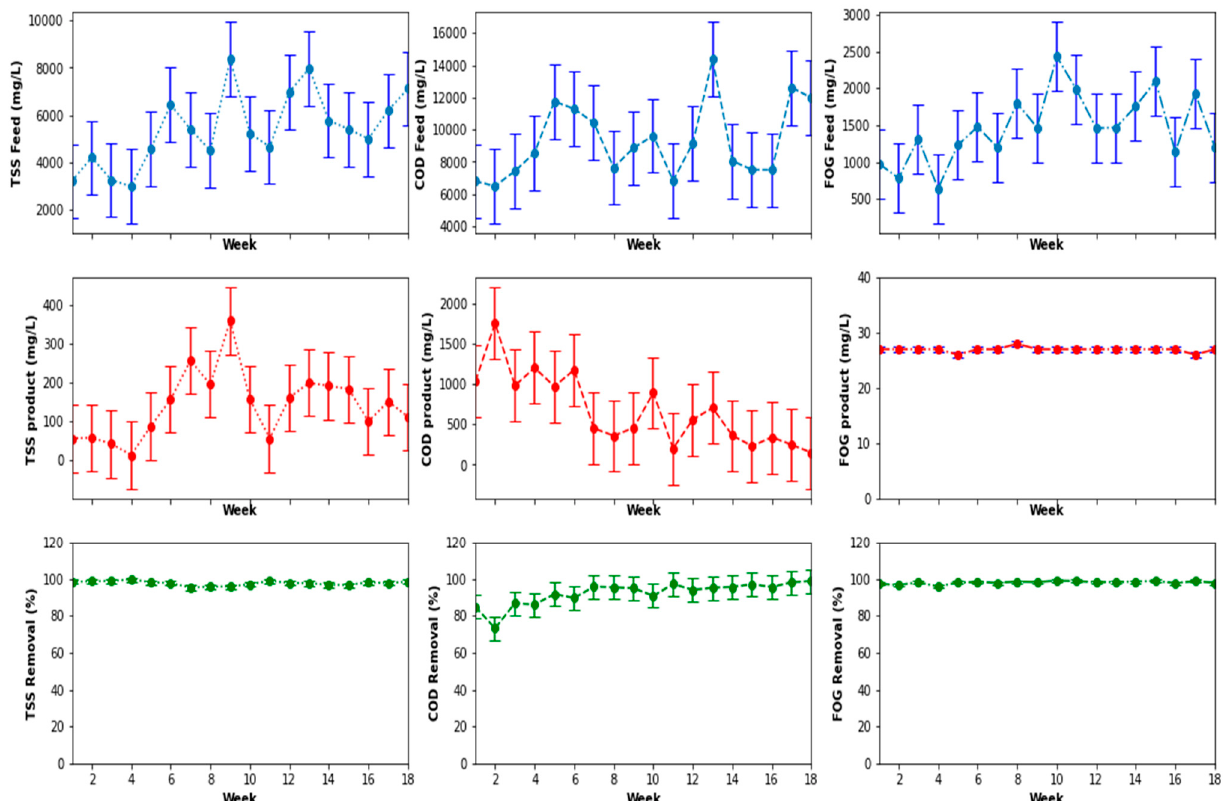
Figure 17. Overall performance of the complete system.